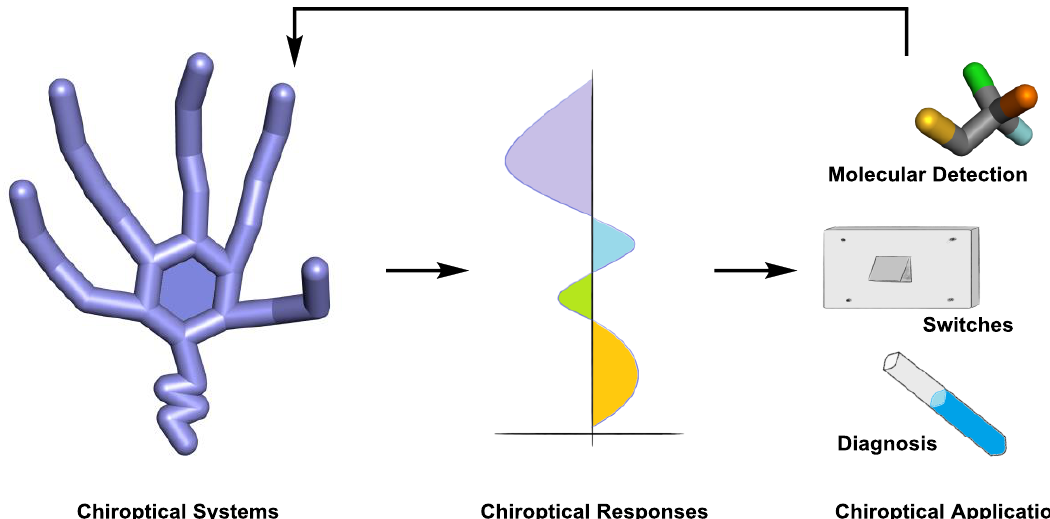
Figure 3. General representation of the applicability of a chiroptical system.